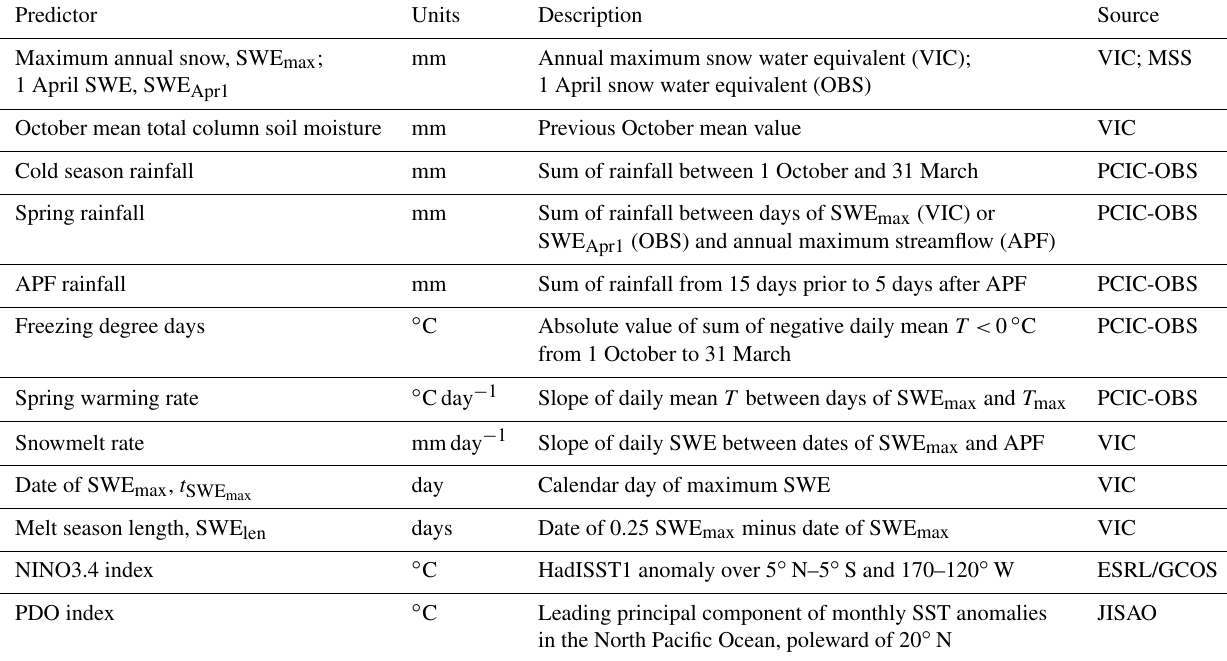
Table 2. Predictor variables and descriptions including their origin. Acronyms are as defined in the text, with the exception of ESRL/GCOS, Earth System Resource Laboratory/Global Climate Observing System (National Oceanic and Atmospheric Administration, NOAA), and JISAO, Joint Institute for the Study of the Atmosphere and Ocean (University of Washington/NOAA).